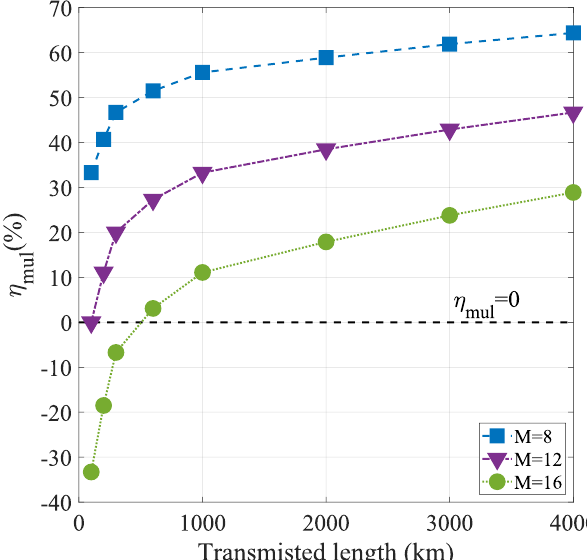
Figure 8. The influence of fiber transmission distance on the optimization performance of real number multiplication under different quantization stages